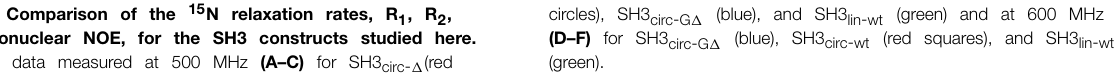
FIGURE 4 | Comparison of the 15 N relaxation rates, R 1 , R 2 , and heteronuclear NOE, for the SH3 constructs studied here. Shown are data measured at 500 MHz (A–C) for SH3 circ - 1 (red